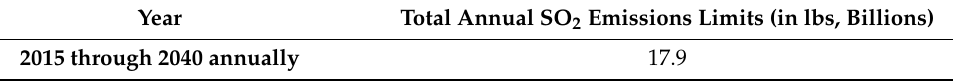
Table A9. Transmission